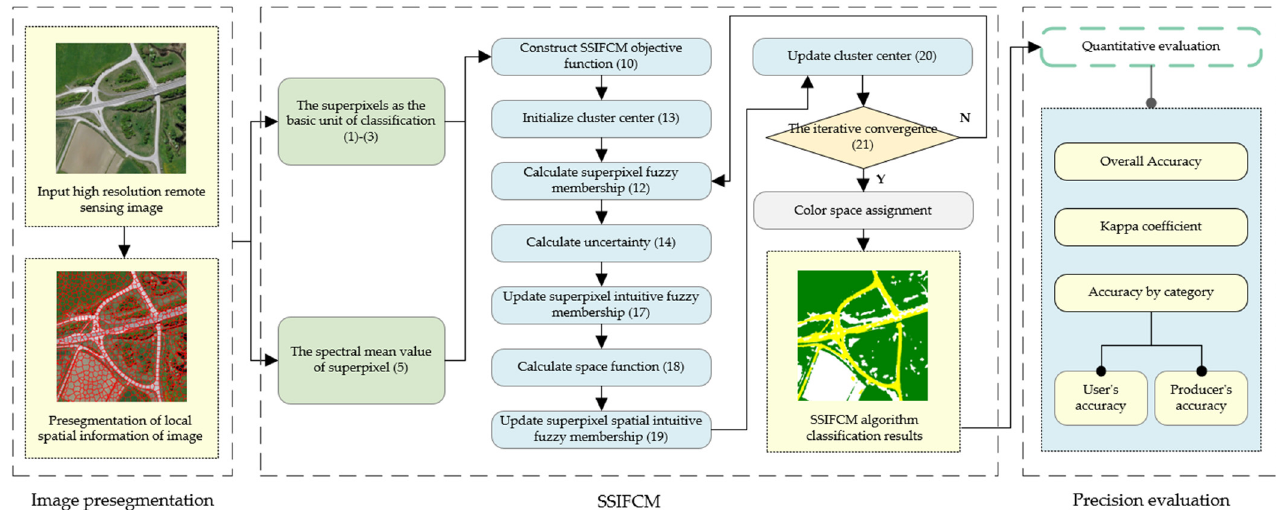
Figure 1. Flow chart of the proposed SSIFCM HSRRS image unsupervised classification algorithm.